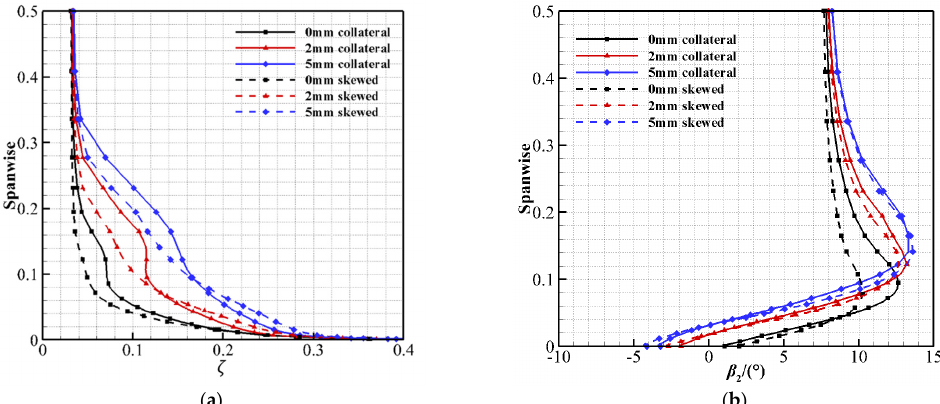
Figure 17. The distributions of mass pitch-averaged outlet total pressure loss coefficient and outlet flow angle of the tandem cascade along the spanwise: ( a ) Total pressure loss coefficient; ( b ) Outlet flow angle.